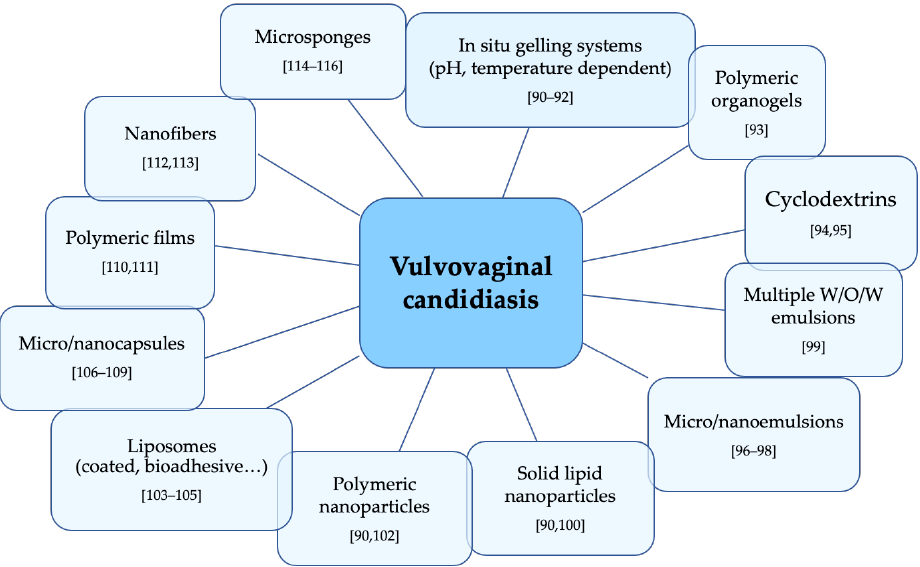
Figure 4. Innovative drug delivery systems for the local treatment of vulvovaginal candidiasis.